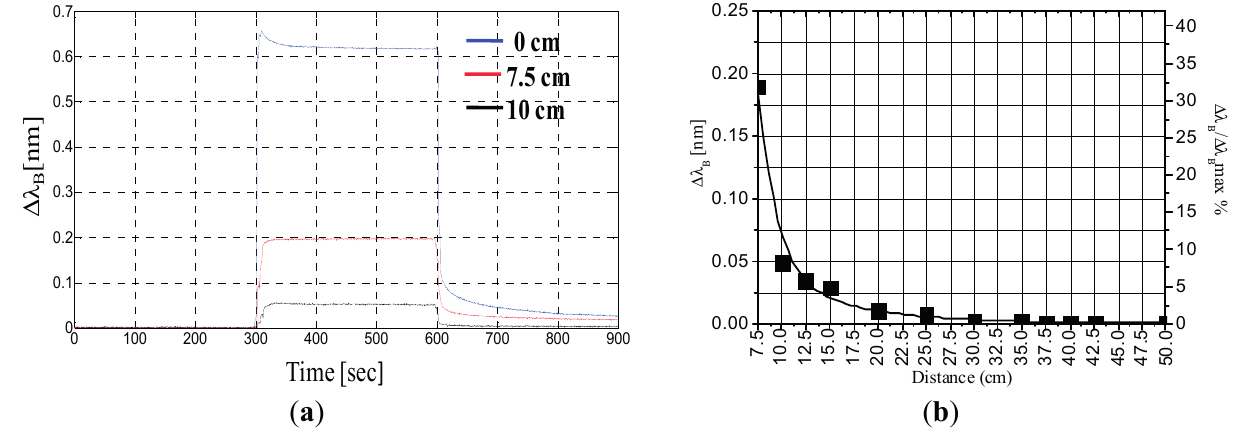
Figure 5. ( a ) Time response of the Bragg wavelength shift at difference distances from the FBG; ( b ) Bragg wavelength shift versus distance from the FBG fitted with an exponential decay.